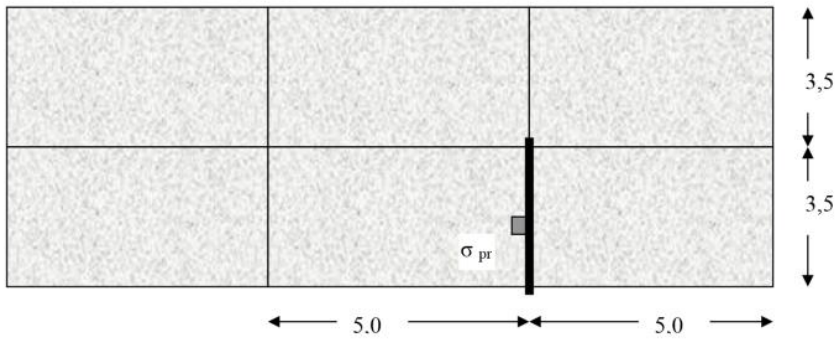
Figure 8. Scheme of concrete slabs.